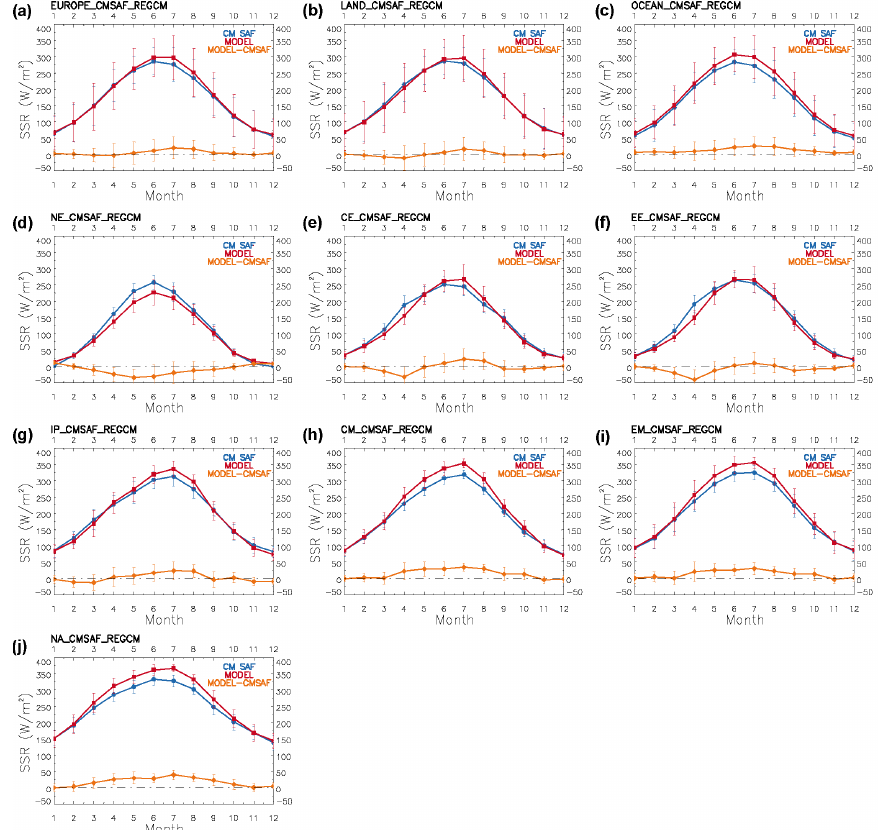
Figure 3. Seasonal variability in RegCM4 SSR (red), CM SAF SSR (blue) and their difference (orange) over (a) the whole of Europe, (b) land, (c) ocean, (d) NE, (e) CE, (f) EE, (g) IP, (h) CM, (i) EM, and (j) NA from MSG SEVIRI